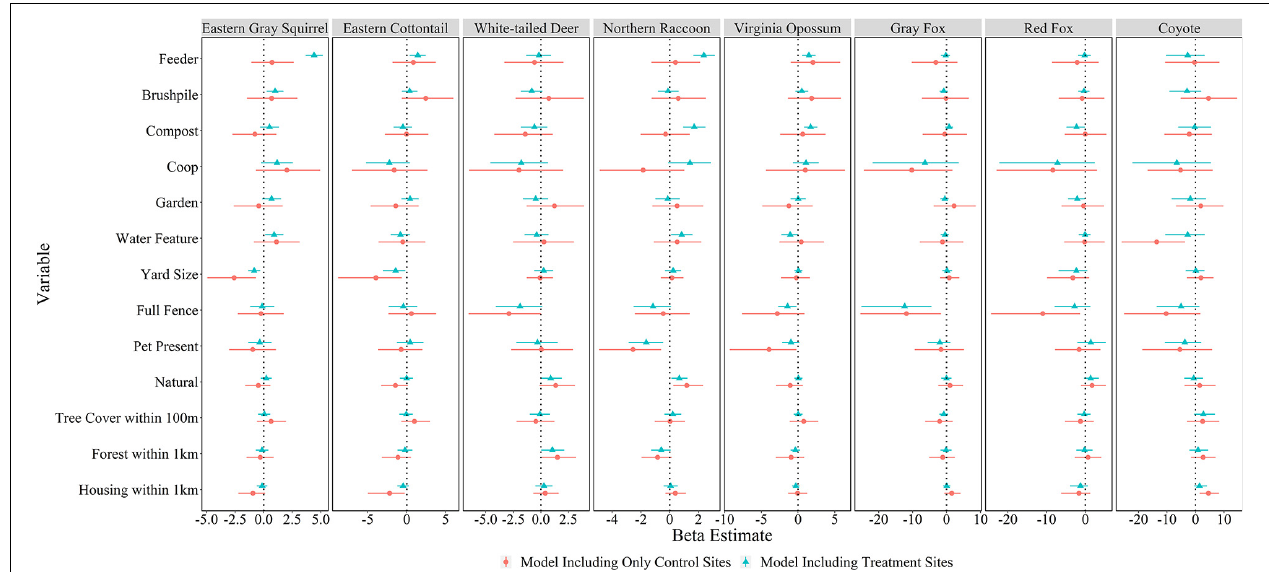
FIGURE 4 | Mean beta estimates (points) and 95% credible intervals (horizontal error bars) for variables explaining mammal relative abundances in residential yards in Raleigh, North Carolina in 2016. Feeders, brushpiles, compost, chicken coops, gardens, and water features represent local-level variables; yard size, full fence, pet present, natural (proportion of yard with natural vegetation), and tree cover within 100 m represent yard-scale variables; and proportion forest within 1 km and housing density within 1 km represent landscape-scale (i.e., neighborhood) variables. Blue markers represent models including treatment sites (cameras facing features) in yards and red markers represent models only including control sites in yards. Thus, feature variables included in control-only models represent whether the feature was present somewhere in the yard, while feature variables for treatment models represent cameras that faced the feature. Credible intervals that overlap the vertical dotted line (Beta = 0) represent variables without a strong influence on species-specific relative